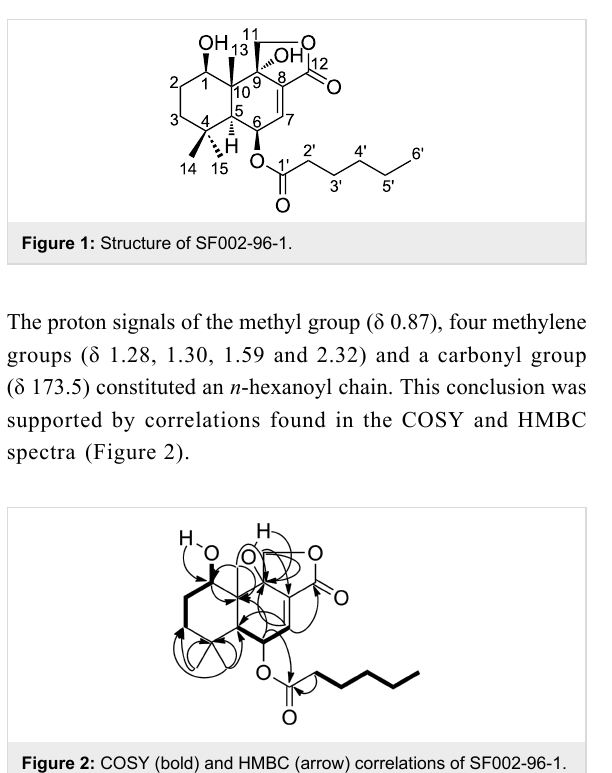
Figure 2: COSY (bold) and HMBC (arrow) correlations of SF002-96-1.